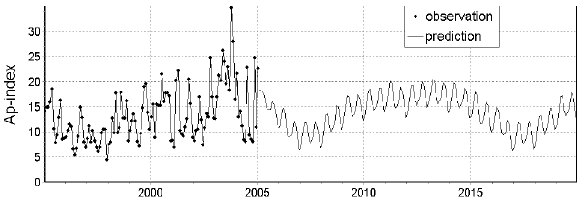
Fig. 6. Monthly distribution of a fraction of days with the magnetic storms ( K p > 5) (a) and its autocorrelation function (b) derived from the data over the 1932–2004 period.